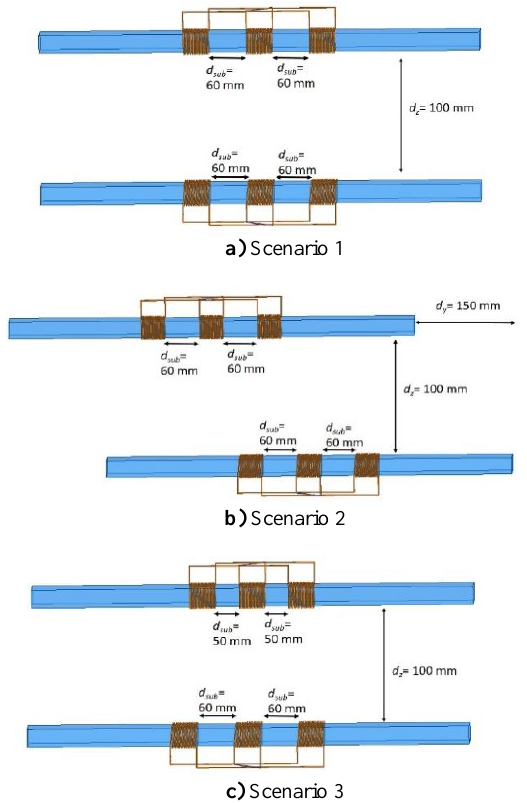
Figure 6. Three expermental scenarios with various coil and sub-coil